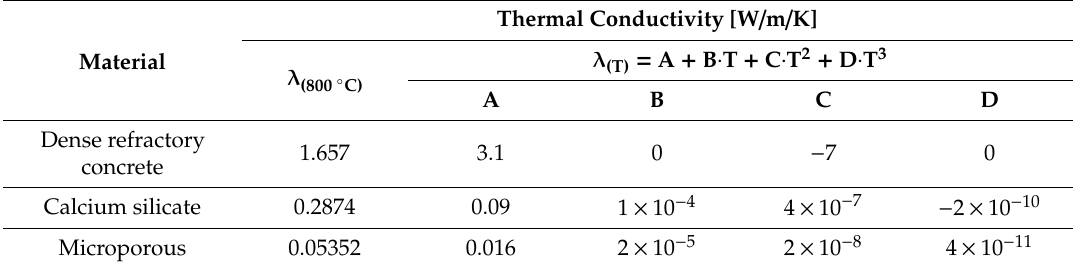
Table 8. Thermal conductivity of furnace insulation.